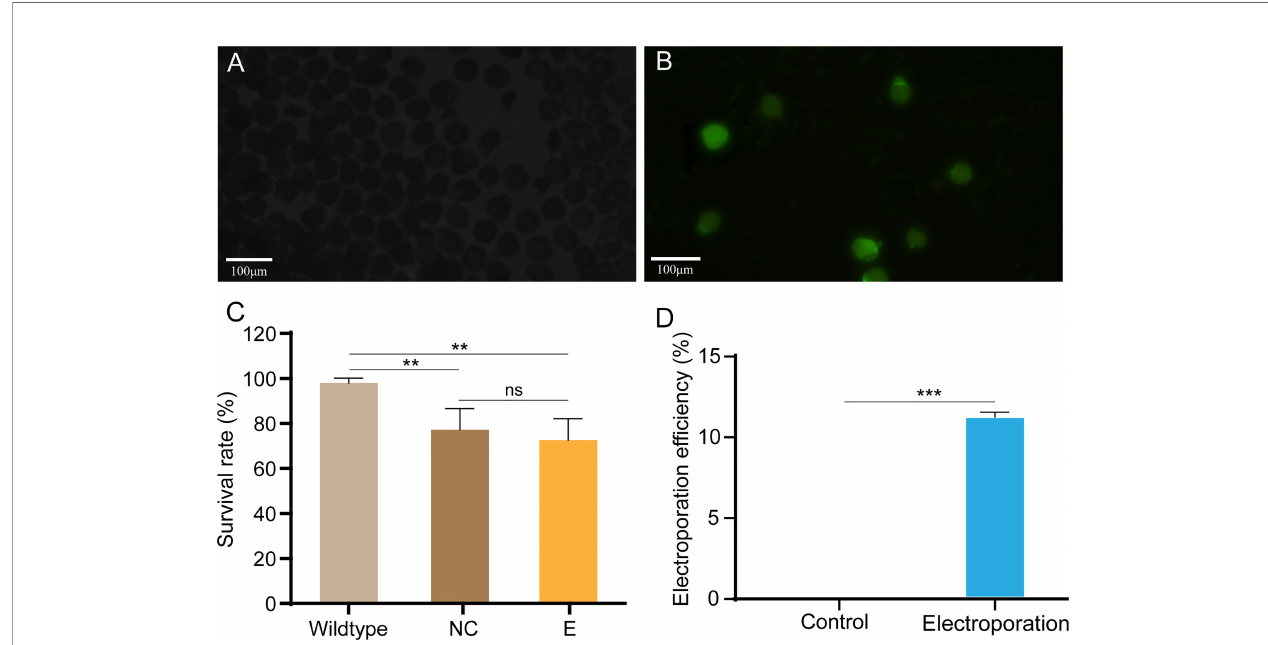
FIGURE 3 | Electroporation ef fi ciency and survival rate of C . gigas angulate larvae after electroporation. (A, B) Early embryos electroporated with Cas9-sgRNA complex (A) or not (B) . Green fl uorescence was only seen in the fertilized eggs after by electroporation (caused by the fl uorescent dye in the electroporation solution). (C) Survival rate of C . gigas angulate larvae after electroporation. Wild type, wild-type control; NC, wild type by electroporation without sgRNA/Cas9 complex; E, electroporation group with sgRNA/Cas9 complex. One-way ANOVA were used for signi fi cance analysis ( p < 0.01, two asterisks; ns, non-signi fi cant). (D) Electroporation ef fi ciency statistics based on fl uorescent dyes. Control, electroporation without dye Lucifer Yellow; electroporation, electroporation with dye Lucifer Yellow. t -Test con fi rmed the signi fi cantly increased number of embryos with green fl uorescence in the electroporation group ( p < 0.001, three asterisks). Error bars represent means ± SD of three independent repeats.